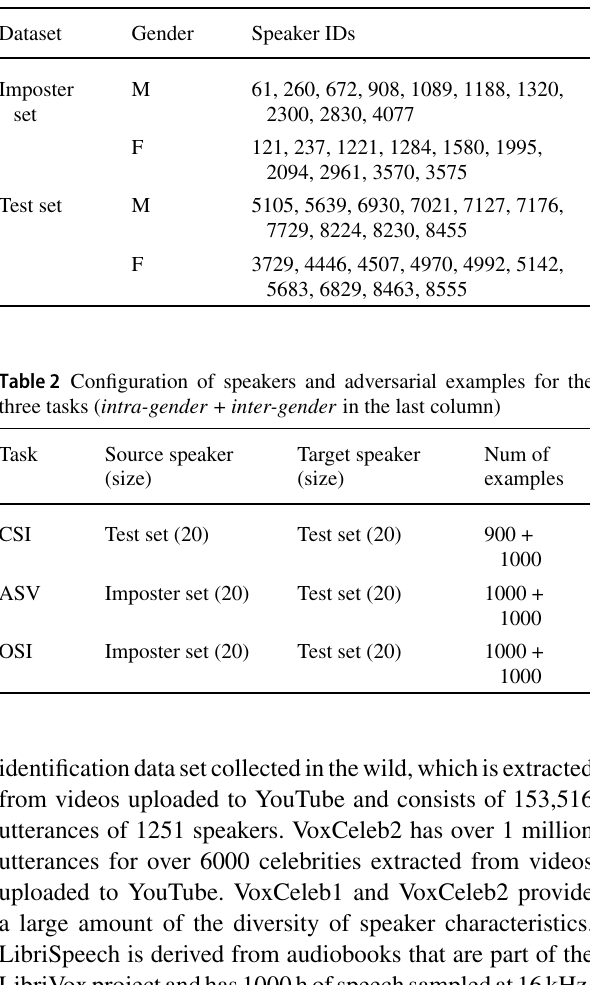
Table 1 The distribution of Imposter and Test sets